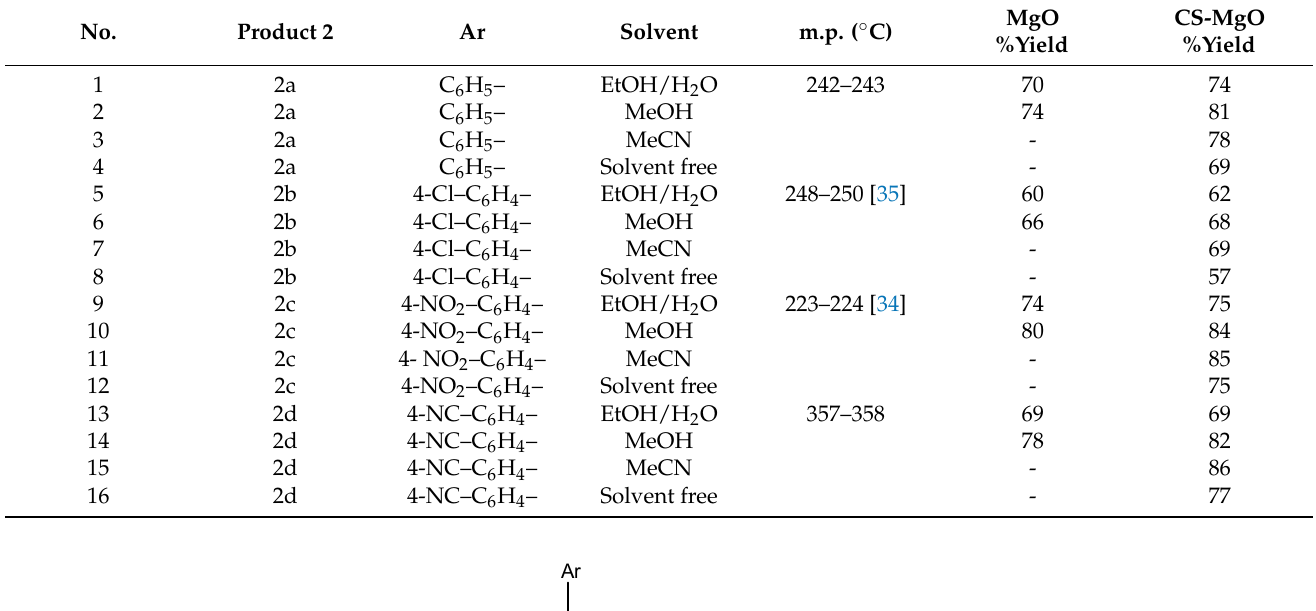
Table 2. Data comparing the catalysts and solvents for one pot reaction forming 6-oxopyrimidine-5-carbonitriles (Scheme 3). No.